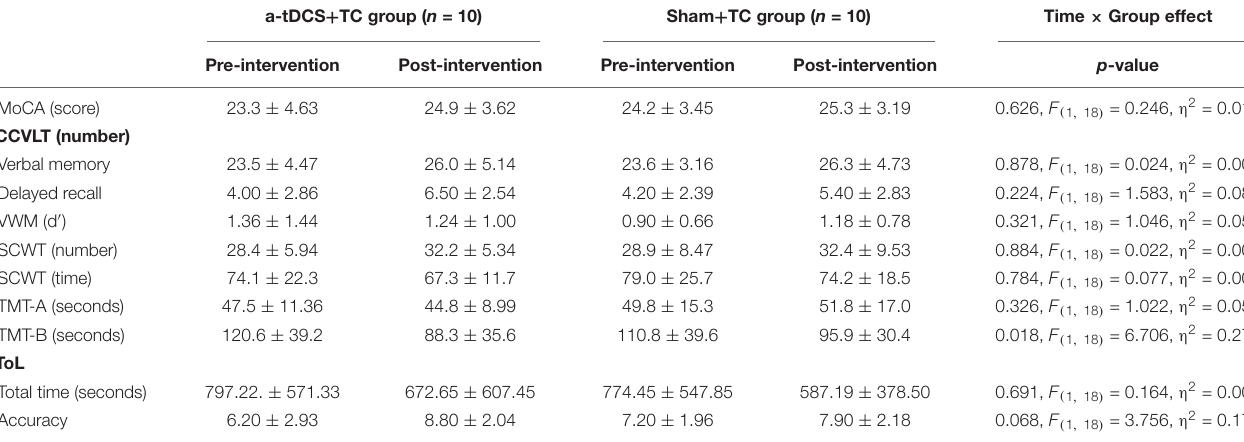
TABLE 3 | Comparisons of cognitive task performance between the a-tDCS + TC group and sham + TC